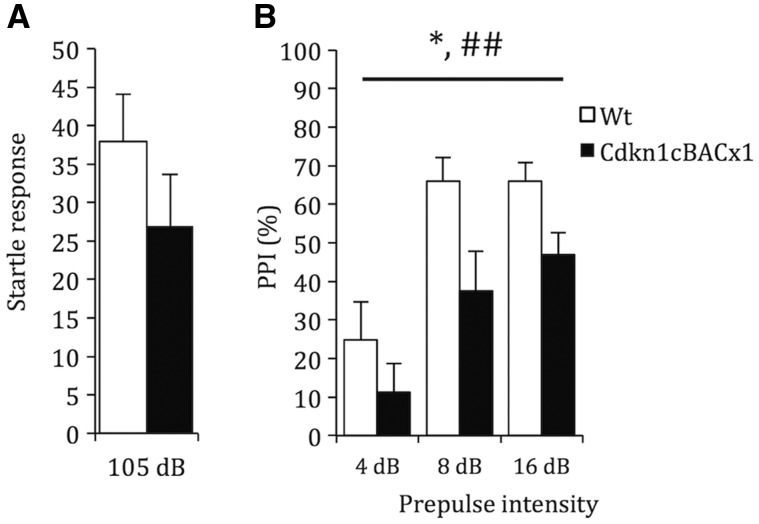
Elevated Cdkn1c expression results in sensorimotor gating deficits. (A) Average ASR to a 105 dB pulse was not affected by genotype (B). However, PPI of the startle response was significantly blunted in Cdkn1cBACx1 animals. Data shown is ± SEM. Main effect of GENOTYPE, *= P < 0.05; main effect of PPI, ##= P < 0.01.